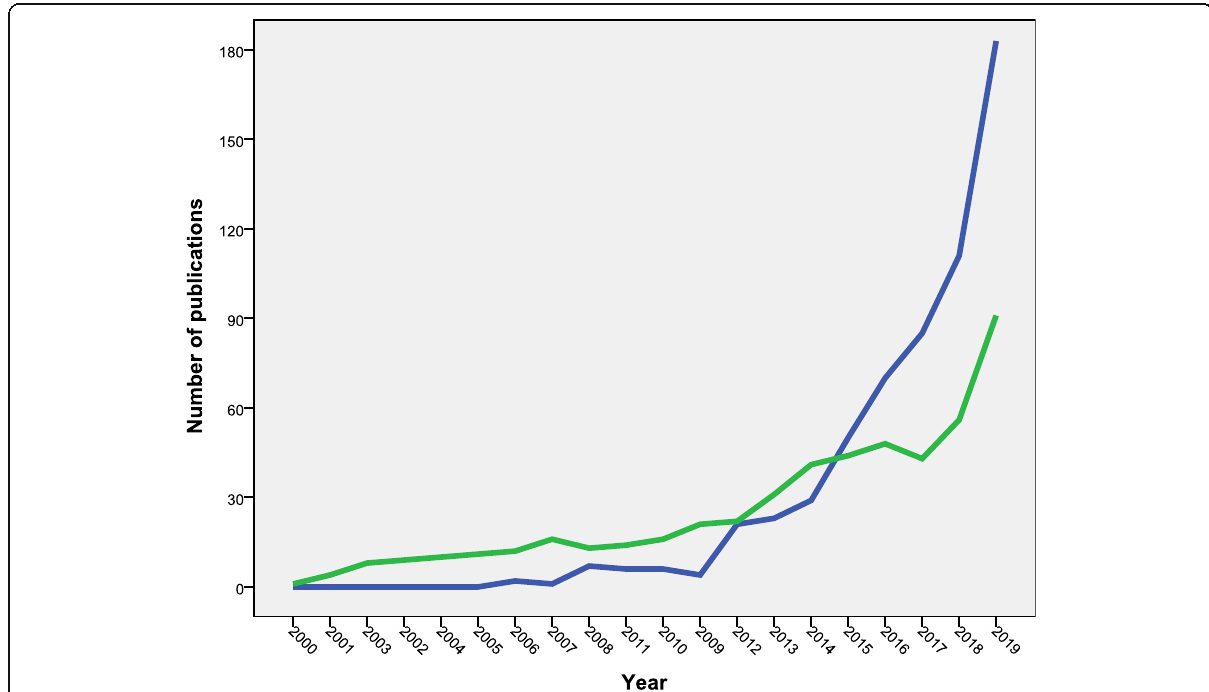
Fig. 3 Comparison of the annual growth of publications on antimicrobial resistance in the environment. The green line represents the annual growth of publications from the USA while blue line represents the annual growth of publications from